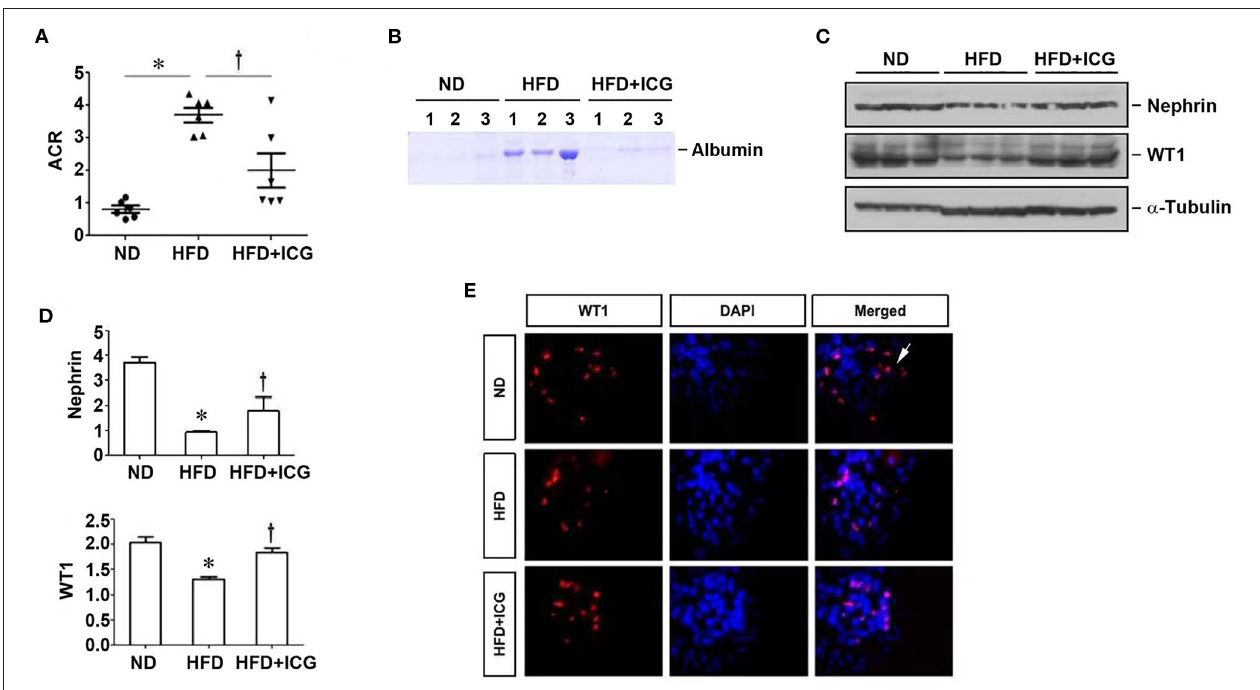
FIGURE 4 | ICG-001 alleviates podocyte injury in mice fed with high-fat diet. Mice were given high-fat diet and administered with ICG-001 or vehicle at 4 weeks after high-fat diet. The experiments were terminated at 13 weeks. (A) ICG-001 reduced albuminuria. Urinary albumin to creatinine ratio (ACR) was presented. (B) Urinary proteins were analyzed on SDS-PAGE. (C,D) Kidney lysates were subjected to Western blot analyses of nephrin and WT1. Representative western blot (C) and quantitative data (D) are shown. (E) Immunofluorescence staining for WT1. ND, normal diet; HFD, high-fat diet; ICG, ICG-001. * P < 0.05, ND vs. HFD, † P < 0.05 HFD vs. HFD + ICG, n =